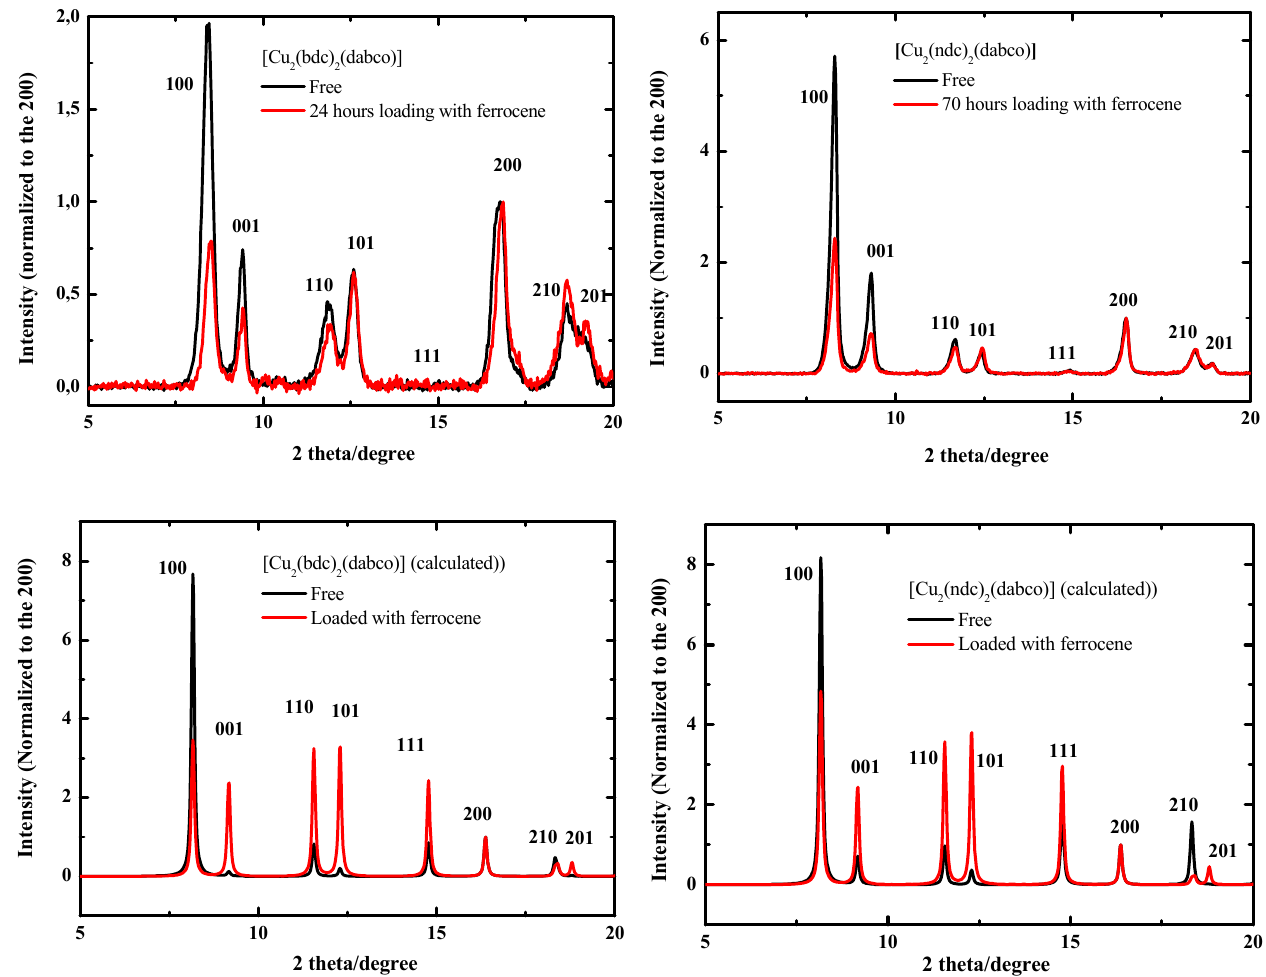
Figure 1. Monitoring with PXRD of the loading of ferrocene inside Cu(bdc)(dabco) and Cu(ndc)(dabco) ( top ) ( 2 ) and compared to the theoretical calculations for both types 1/2 of MOFs after loading with ferrocene ( bottom